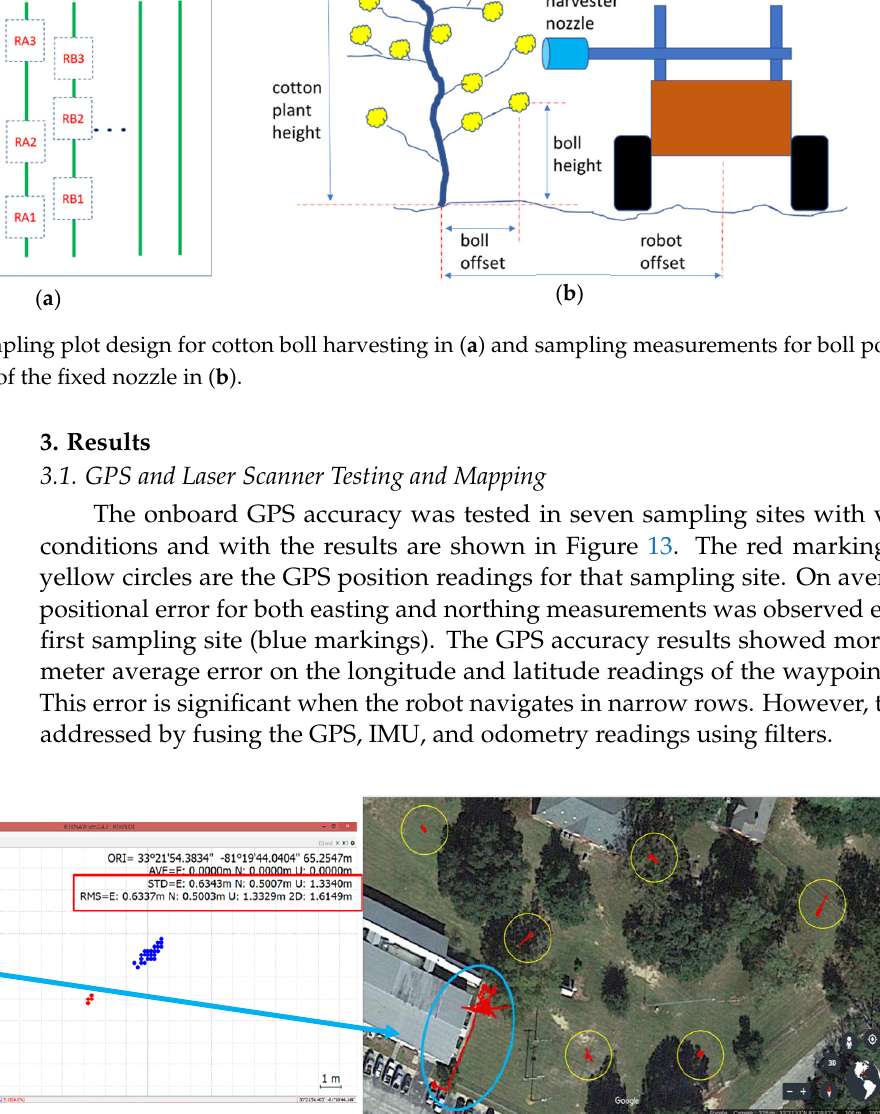
Figure 12. Random sampling plot design for cotton boll harvesting in ( a ) and sampling measure- ments for boll position to determine the position of the fixed nozzle in ( b ).